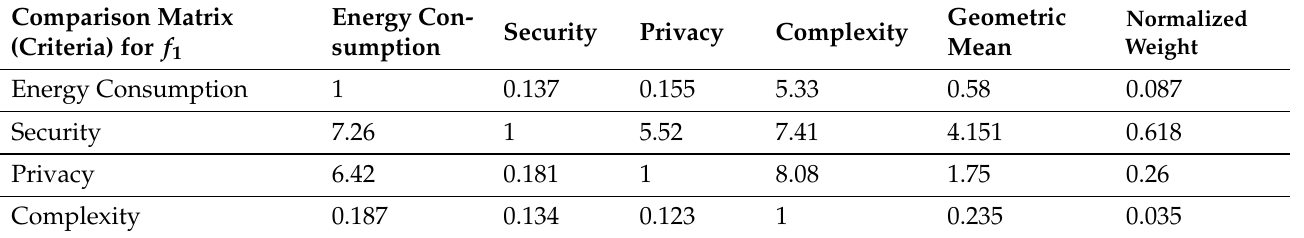
Table 5. Pairwise comparison matrix of criteria for object